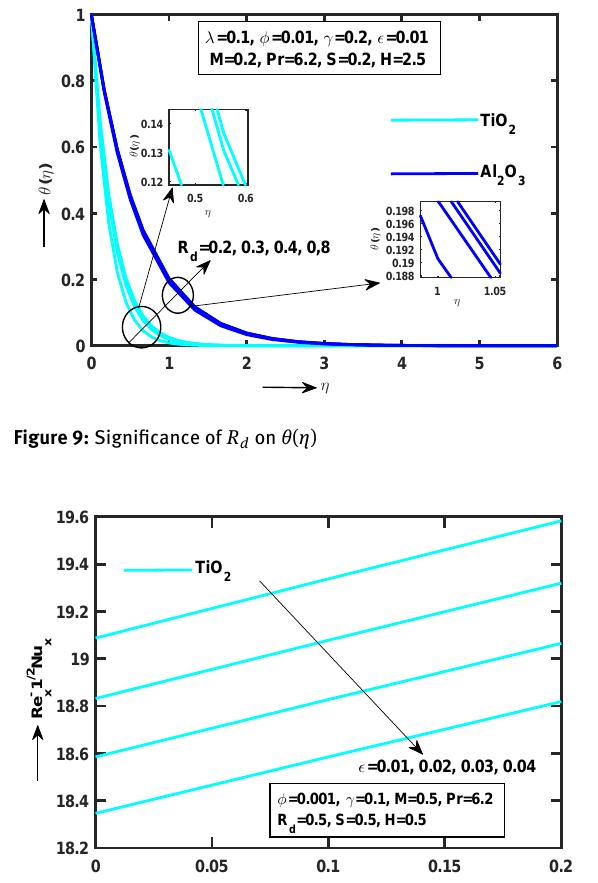
Figure 10: Significance of ϵ on Re